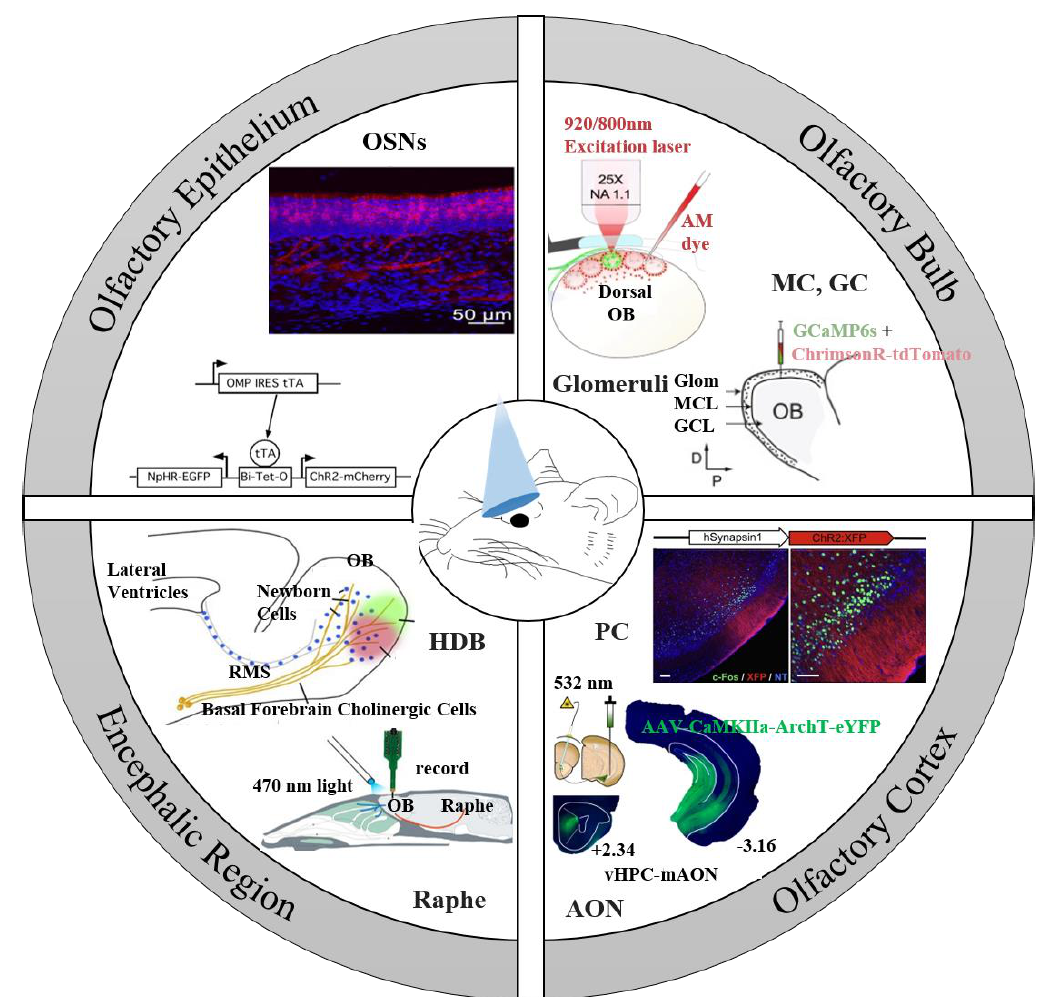
Figure 1. Application of optogenetics in various parts of the olfactory system. Olfactory epithelium: ChR2 is expressed in all OSNs to test whether mice can perceive the time of olfactory stimulation [26] . Olfactory bulb: ChR2 was expressed in a single glomerulus to study its response to optogenetic stimulation [27] . Express ChrimsonR-tdTomato in mitral cells and granule cells of mice to explore the coding characteristics of its perception detection [28] . Olfactory cortex: explore whether light-activated piriform cortex neurons of different subtypes can induce different behaviors [29] . Archaerhodopsin is used to inhibit the hippocampus dominating the AON subregions, revealing the principle of odor memory [30] . Encephalic region: ChR2 was expressed in the dorsal raphe nucleus to study the olfactory regulation of serotonin [31] . Express ChR2 in HDB and explore the olfactory perceptual learning involving cholinergic neurons [32] . Reproduced with